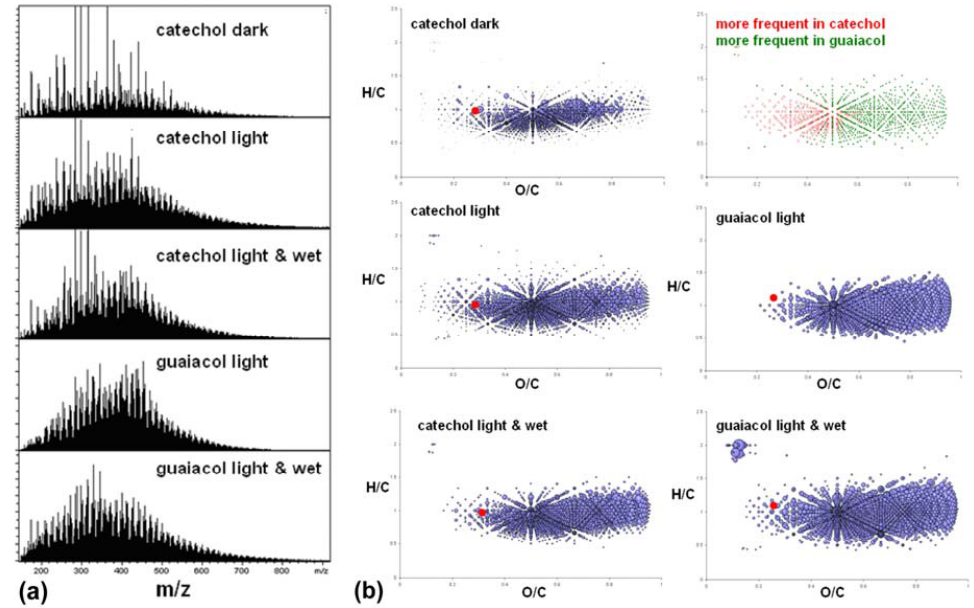
Fig. 11. ICR-FT/MS spectra in the m/z range 150 to 900 (a) and Van Krevelen diagrams (b) showing the distribution of the H/C and O/C ratios of the ICR-FT/MS data in the CHO compositional space as a function of precursor, light and wet.